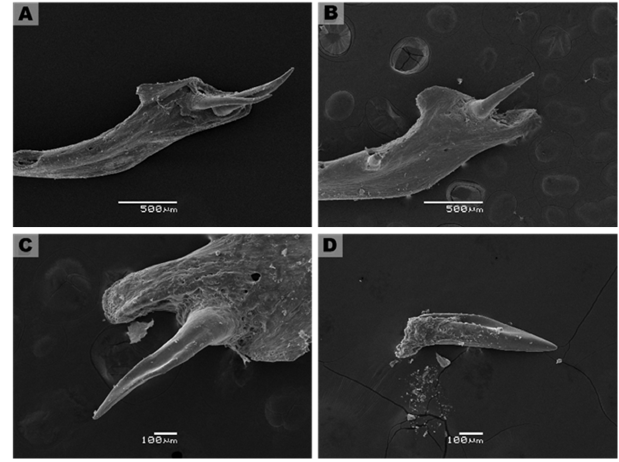
Figure 8. Anatomical and structural characteristics of the fang of neonate specimens of Galvarinus ch. chilensis (lingual view). Specimens used: MZUC ( A ) 45,031 ( B ) 45,032 ( C ) 45,033, and ( D ) 45,036.